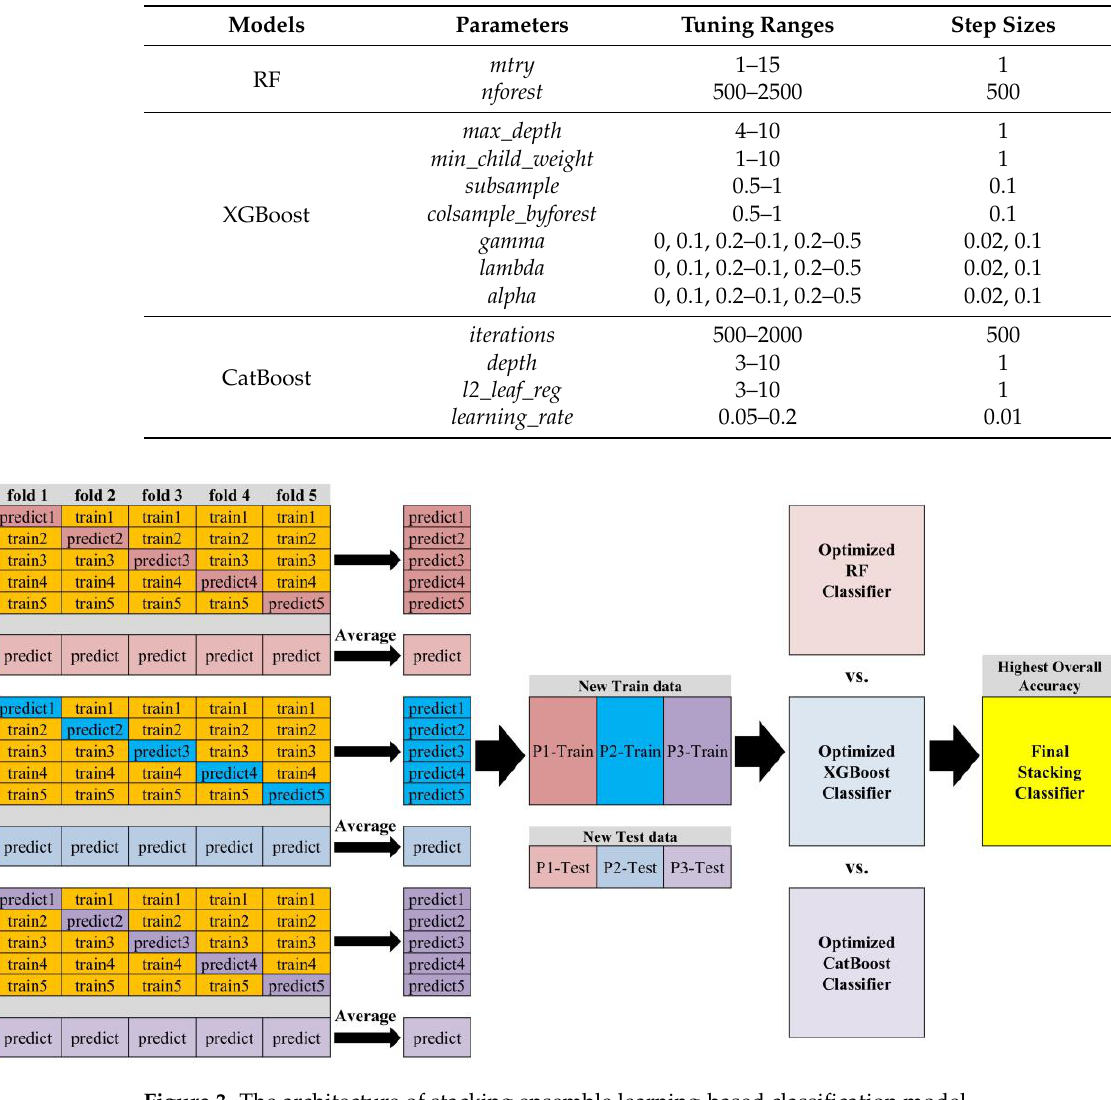
Figure 3. The architecture of stacking ensemble learning-based classification model.